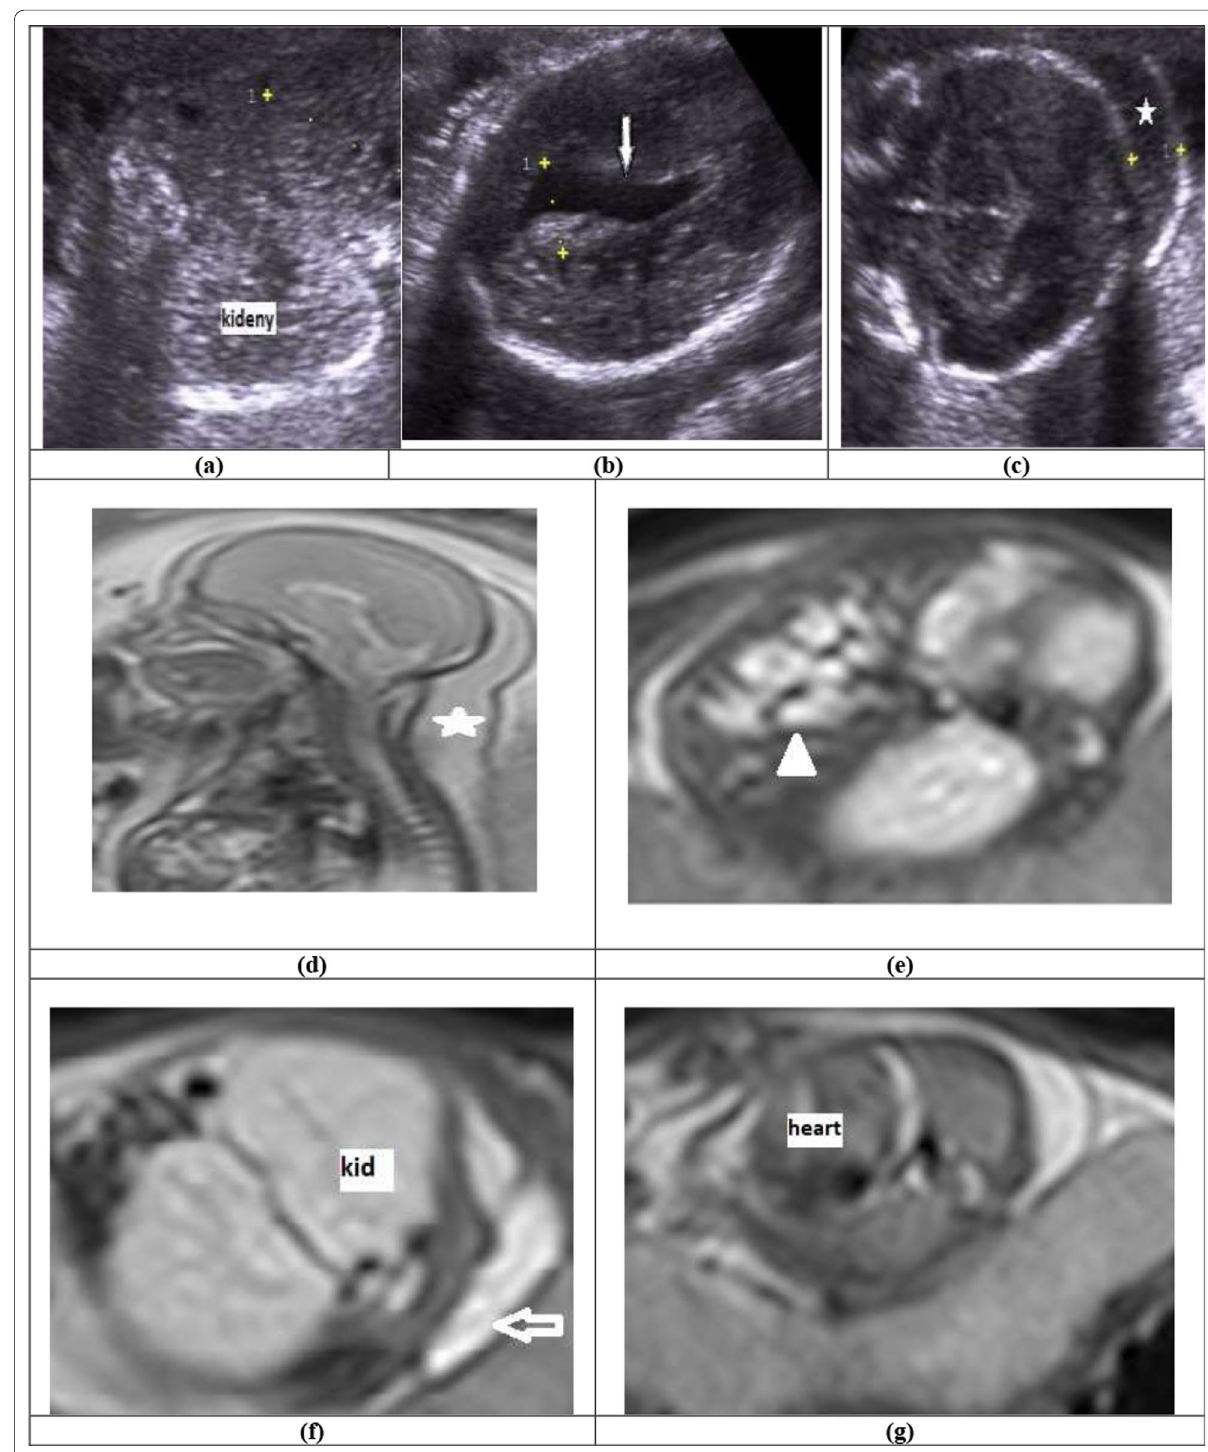
Fig. 3 25-year-old pregnant female at 21 weeks of gestation presenting with oligohydramnios. Prenatal ultrasound: a – c revealed bilateral enlarged echogenic kidneys associated with ectatic lateral ventricles (white arrow) and shallow posterior fossa with increased nuchal fold (asterisk). Prenatal fetal MRI sequences revealed bilateral enlarged kidneys (infantile polycystic kidneys). Associated with IHBD (Caroli disease) (arrow head), spina bifida with meningocele (hollow arrow), lung hypoplasia and diffuse increase in nuchal fold …over all features matching with Meckel–Gruber syndrome: d sagittal e – g axial T2-weighted SSFSE sequence. Diagnosis was Meckel–Gruber